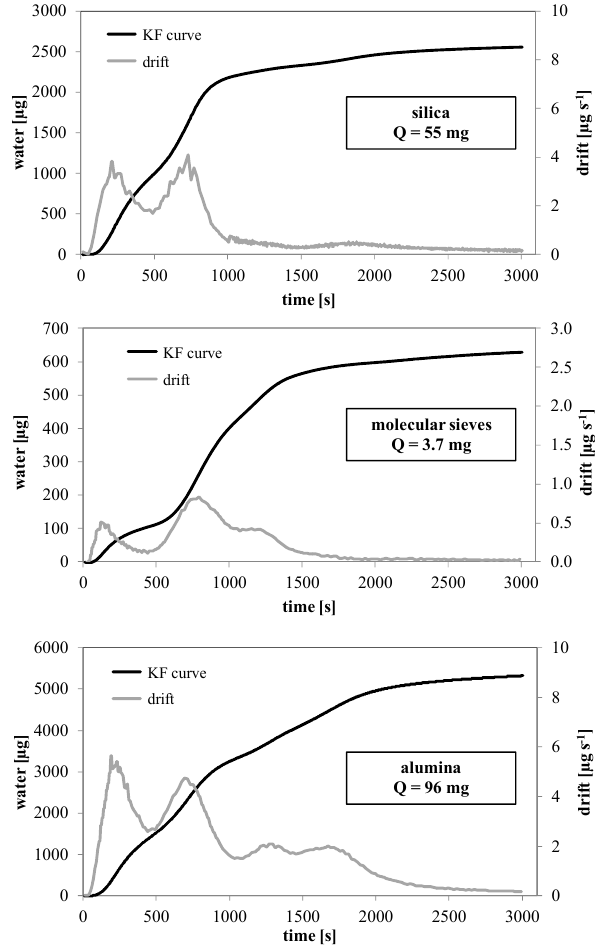
Fig. 4. Karl-Fisher curves of SiO 2 (upper panel), molecular sieves (middle panel) and Al 2 O 3 (lower